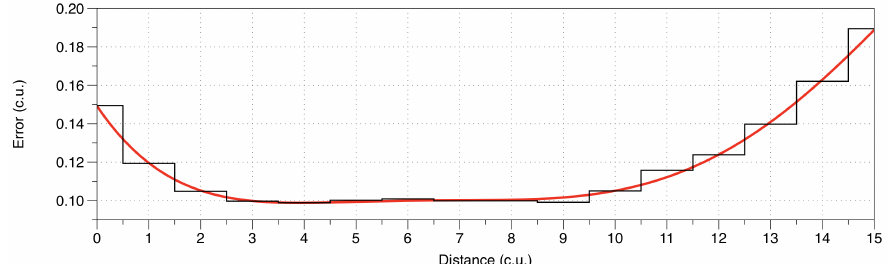
Figure 1. Example of random error data for a single beacon-tag pair. The red line is the hypothetical behavior; black stepped line is the result of a binned running standard